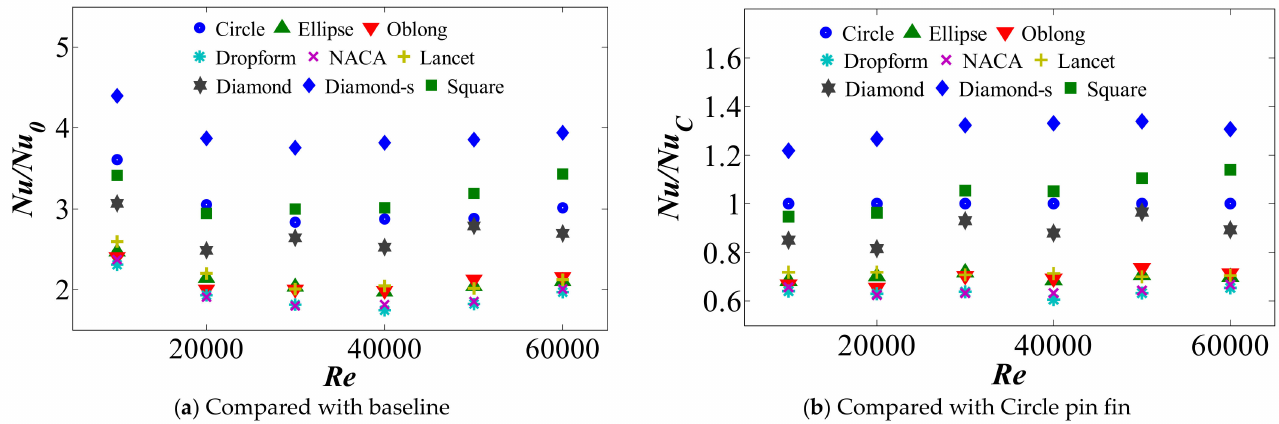
Figure 12. Heat transfer enhancement of different pin